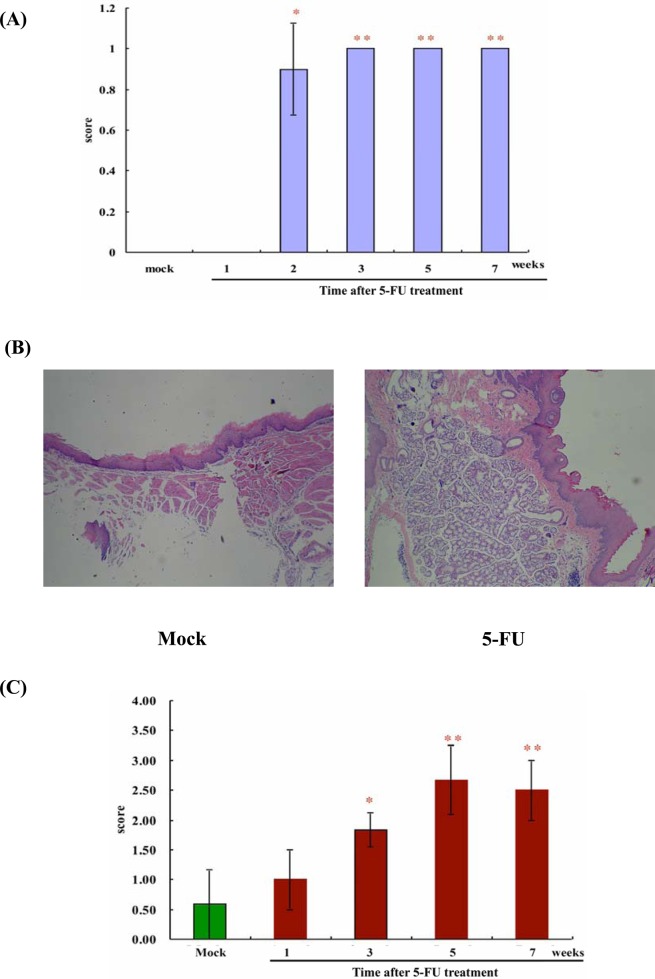
Macroscopic and microscopic examinations of the oral mucosa following 5-FU administration.BALB/c mice were intraperitoneally administered with PBS (mock, the control group) or 5-FU and investigated at indicated periods. (A) Macroanalysis. Oral mucositis was induced via intraperitoneal administration of 5-FU. The oral cavity of each mouse was evaluated. Erythema and hyperemia of oral mucosa were significantly observed in the second week after 5-FU administration (p<0.05). During the third to seventh week period, the significant difference between 5-FU-induced oral mucositis and the control group (mock) persisted (p<0.01). (B) Microscopic features of the oral mucosa. In the fifth week, three mock mice and four 5-FU-treated mice were sacrificed and the sections were stained with H&E and observed using light microscope. Magnification 100×. Photos are representative images. Histopathologically, the oral mucosa of mice subjected to 5-FU-induced oral mucositis showed accentuated vasodilatation, intense cellular infiltration with neutrophil prevalence, hemorrhagic areas, edema, and extensive ulcers, compared with the control group (mock). (C) According to the oral mucositis microscopic analysis scoring system, a significant difference was noted in the third week for the first time (p<0.05), and the peak influence was noted in the fifth week (p<0.01). Then the inflammatory condition was relieved in the seventh week investigation (red column: 5-FU treatment; green column: mock, the control group). Values are mean ± standard error. *p<0.05, **p<0.01, compared with the control group (mock).